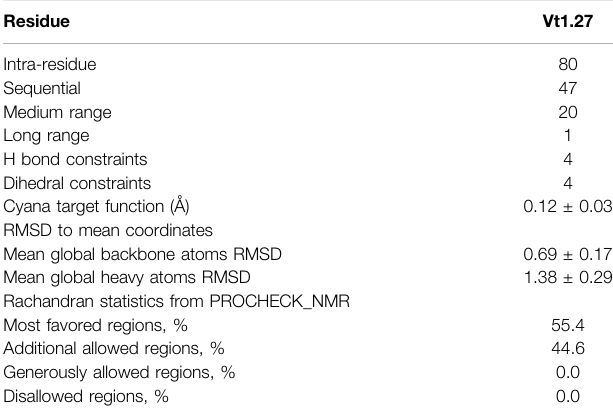
TABLE 1 | Structural statistics of the ensemble of 20 structures of Vt1.27 after CYANA calculation. Residue Vt1.27